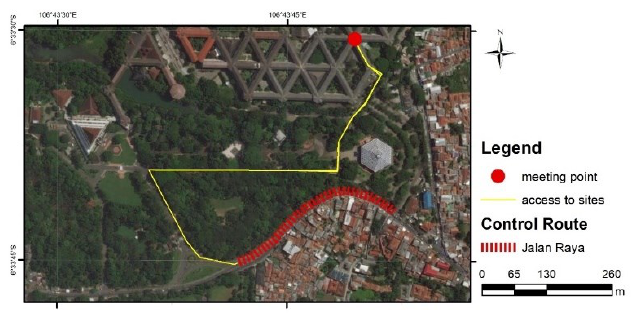
Figure 2. Control